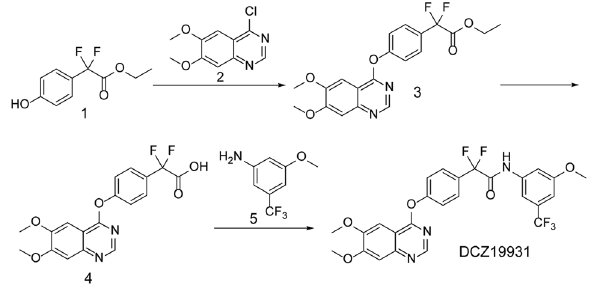
Figure 1. Synthesis of